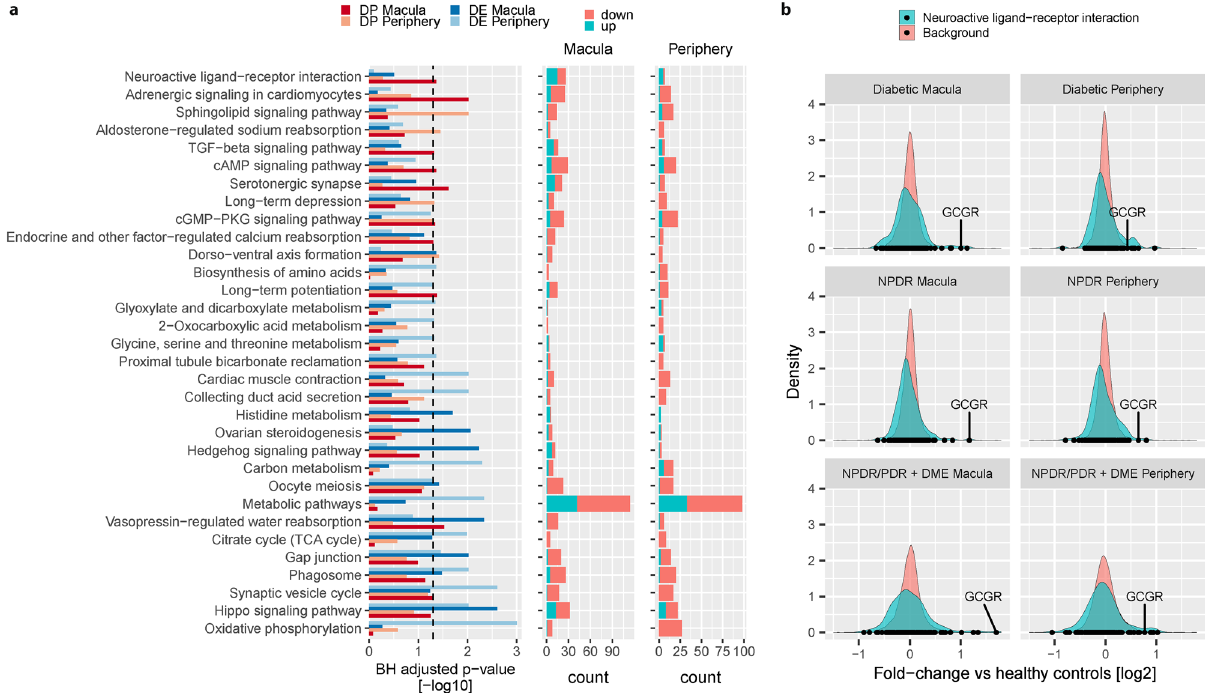
Figure 4. Molecular pathways associated with different disease stages of DR: ( a ) Barplot showing BH-adjusted p values of KEGG 2016 pathway enrichment analysis for each the four identified groups of disease-associated transcripts (left panel, Oxidative phosphorylation BH adjusted p value = 1.15e−07). Only pathways with BH-adjusted p value < 0.05 are shown. Middle and right panel indicate the direction of change in NPDR/ PDR + DME samples vs healthy control for each of the significantly changing transcripts included in a given pathway (Middle panel: Macula; Right panel: Periphery). ( b ) Distribution of fold-changes for each sample group vs healthy controls for transcripts associated with the Neuroactive ligand–receptor interaction pathway. Black dots indicate fold-changes of individual genes in the Neuroactive ligand–receptor interaction pathway. As example, we specifically plot Glucagon Receptor (GCGR). The background distribution shows fold-changes [log2] of all transcripts not included in the